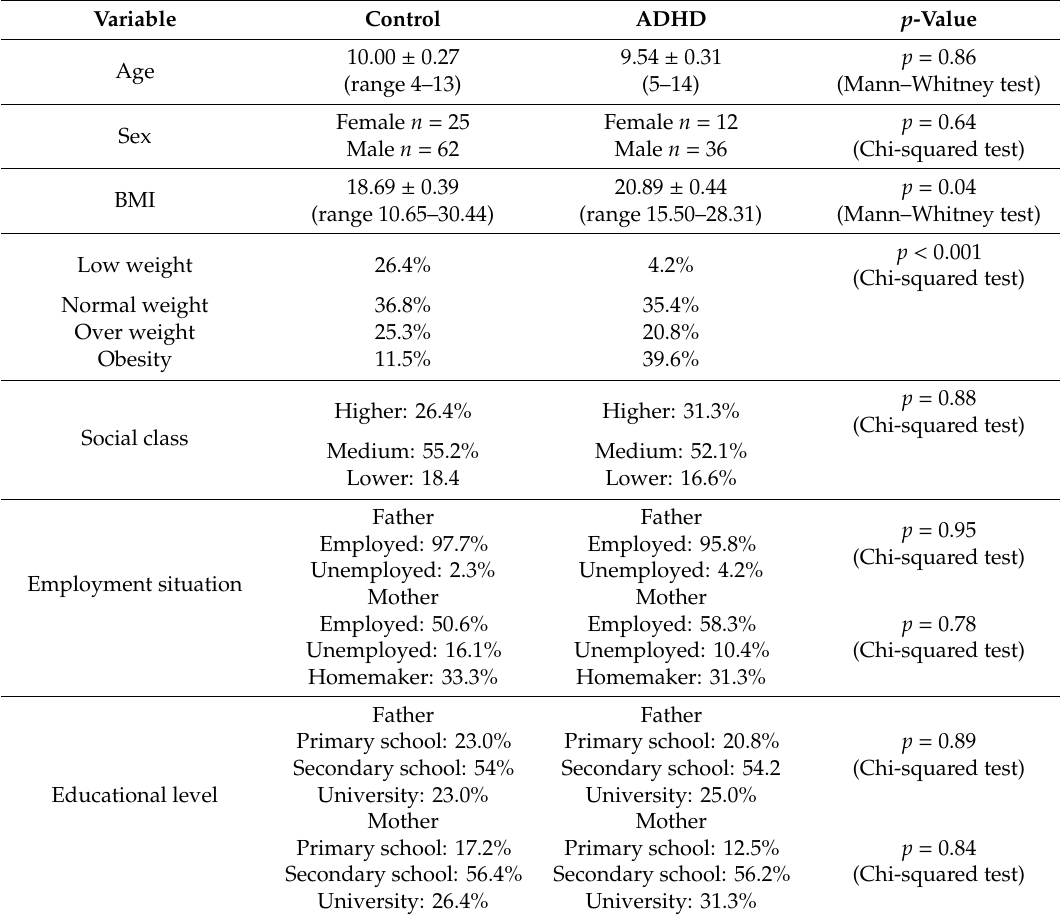
Table 1. Characteristics of the study